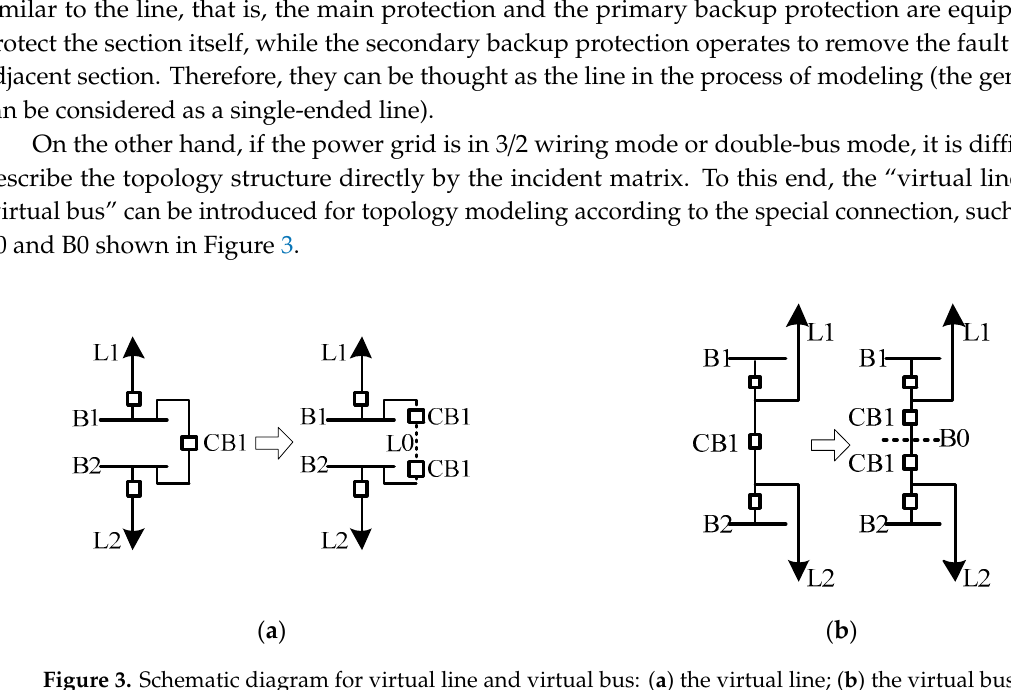
Figure 3. Schematic diagram for virtual line and virtual bus: ( a ) the virtual line; ( b ) the virtual bus.